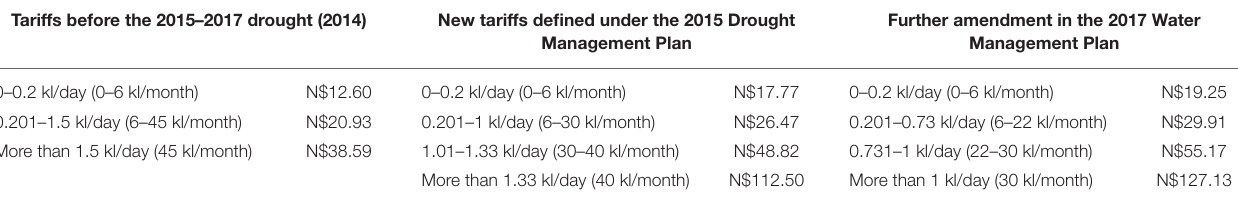
TABLE 1 | List of the tariff structure changes implemented during the drought as part of water demand management (WDM) initiatives. Tariffs before the 2015–2017 drought (2014) New tariffs defined under the 2015 Drought Management Plan